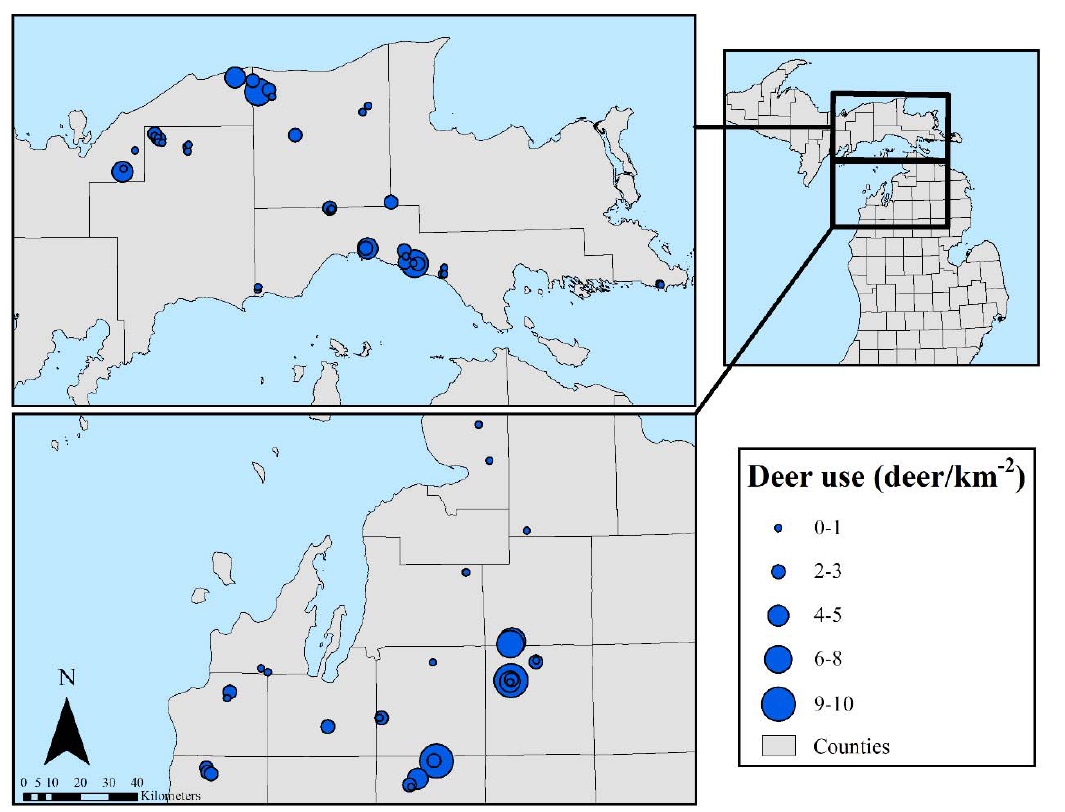
/ km − 2 ) across study sites ( n = 69).